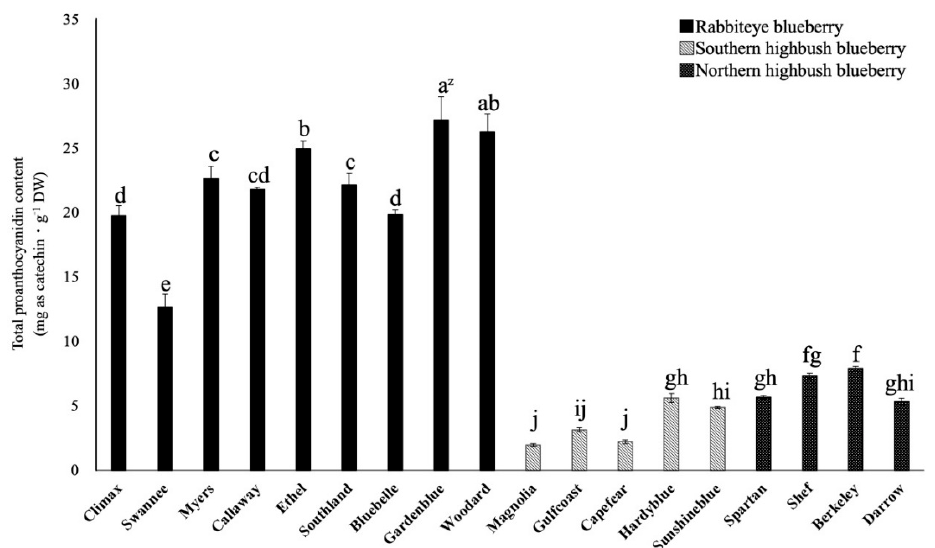
Figure 3. Comparison of the total proanthocyanidin content in mature leaves of blueberry varieties. z Different letters among varieties represent significant differences at 5% level as determined by Tukey’s multiple range test (n = 3).